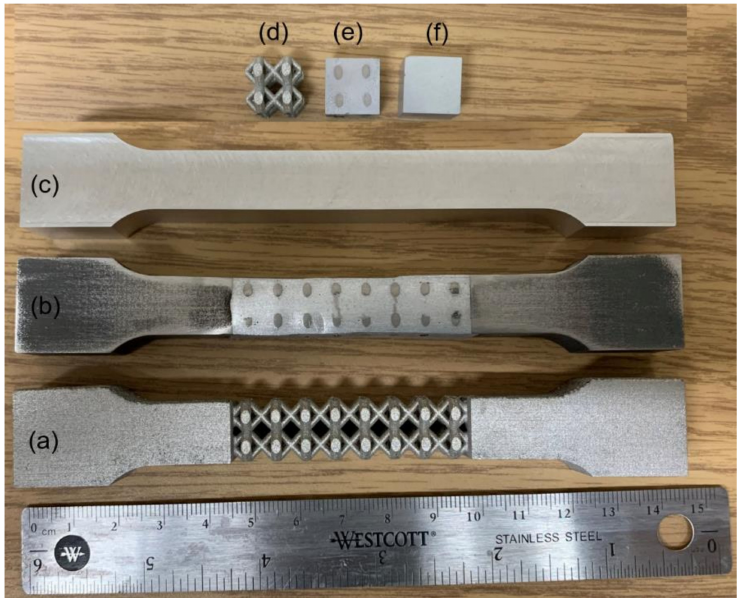
Figure 3. An image of the experimental samples: ( a ) stainless steel lattice dog-bone; ( b ) stainless steel/aluminum composite dog-bone; ( c ) bulk aluminum dog-bone; ( d ) stainless steel lattice cube; ( e ) stainless steel/aluminum composite cube; ( f ) bulk aluminum